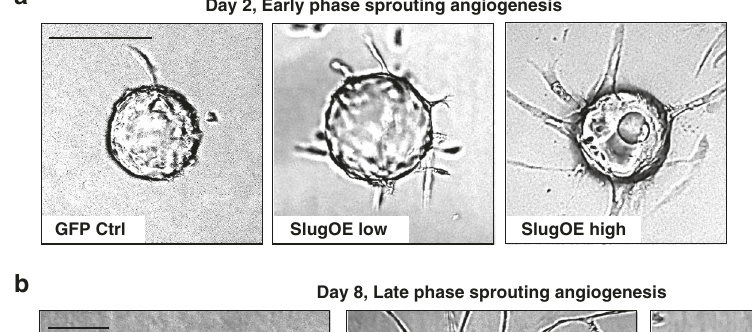
Fig. 3 Slug overexpression in EC disrupts vascular morphogenesis. a SlugOE in EC induces increased tip cell formation (middle) and accelerates sprouting (right) in a dose-dependent manner during early phase sprouting angiogenesis in the fi brin-gel bead assay. Scale bar: 100 µ m. b SlugOE at low levels in EC leads to dilated lumens (middle), and fragmentation of the sprouts at high levels (right) in the fi brin-gel bead assay. Scale bar: 100 µ m. c SlugOE at low levels in EC leads to dilated lumens (middle), and fragmentation of the network at high levels (right) in the in vitro vascularized micro- organ model of vasculogenesis. Scale bar: 100 µ m. This is quanti fi ed as d reduced number of junctions (GFP n = 20 devices, SlugOE n = 25 devices. p < 0.0001), e reduced total vessel length (GFP n = 20 devices, SlugOE n = 25 devices. p < 0.0001), f increased average vessel diameter (GFP n = 11 devices, SlugOE n = 16 devices. p < 0.0001), and g increased average lacunarity (GFP n = 20 devices, SlugOE n = 25 devices. p < 0.0001). Data represent mean ± SEM. Two-tailed unpaired equal-variance t -test. * p < 0.05, ** p < 0.01, *** p < 0.005. Source data are provided as a Source Data fi